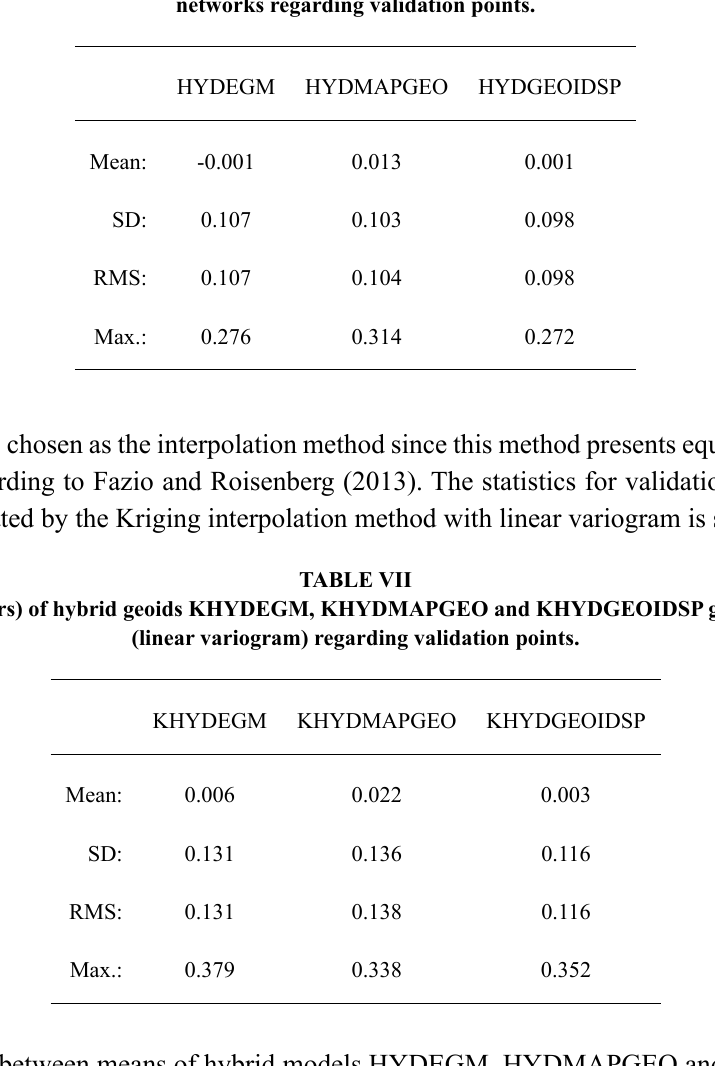
Consistency (in meters) of hybrid geoids HYDEGM, HYDMAPGEO and HYDGEOIDSP generated by linear RBF networks regarding validation points.